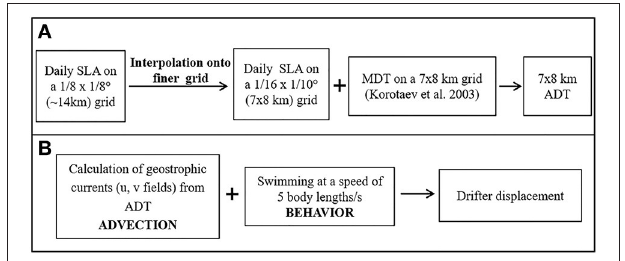
FIGURE 3 | Schematic diagram of data processing and drifter (anchovy) displacement calculation performed in this study: (A) Daily Sea Level Anomaly (SLA) fields provided by AVISO + were interpolated spatially onto a 7 × 8 km grid. The mean dynamic topography (MDT) compiled by Korotaev et al. (2003) was added to the SLA fields to obtain Absolute Dynamic Topography (ADT) fields from which geostrophic currents were computed. (B) Anchovy swimming behavior added to advection by currents results in net drifter